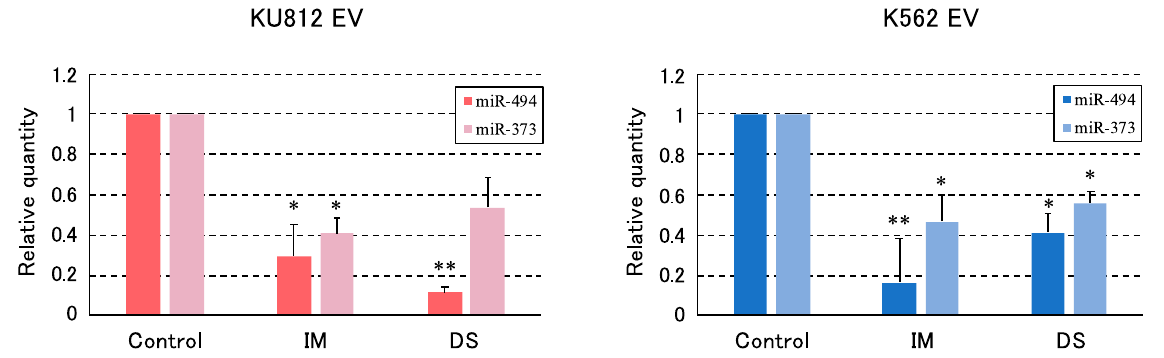
Figure 3. The validations of two miRNA by qRT-PCR ( n = 3). miR-494 and miR-373-5p were validated by qRT-PCR using TaqMan probe. The expressions of miRNAs were normalized by spiked cel-miR-39 and shown as relative expressions to control. Each value represents the mean ± SEM ( n = 3). Asterisks indicate statistical significance (* p < 0.05, ** p < 0.01). (IM: imatinib, DS: dasatinib).